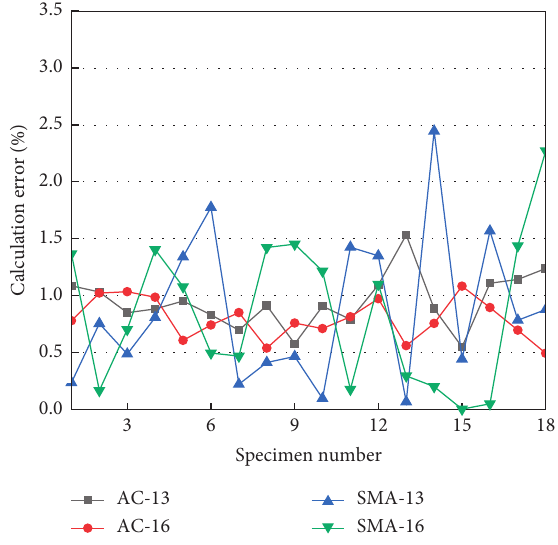
Figure 12: The results of the established